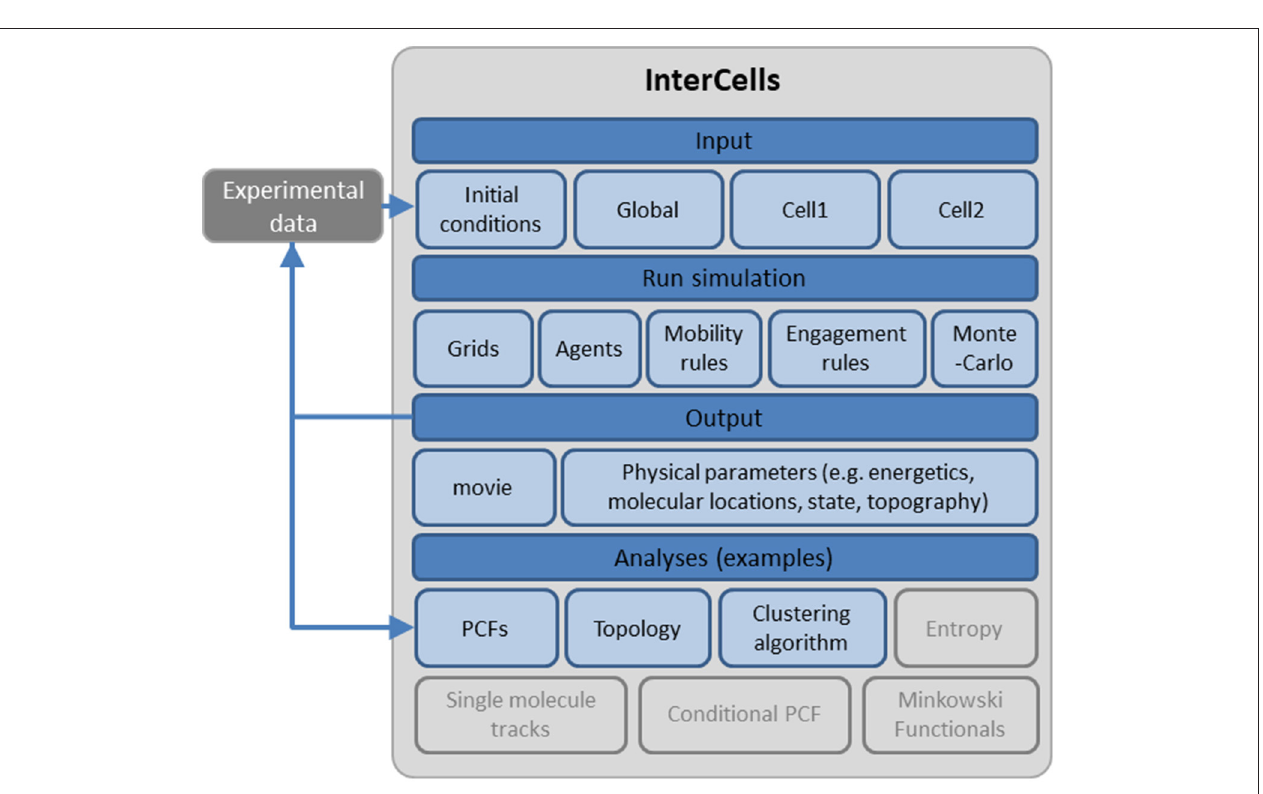
Specifically, coordinates were taken for TCR ζ molecules (in green). To complete the initial conditions, the initial coordinates of CD11 and CD45 molecules were manually determined via the available tools of the simulation in the